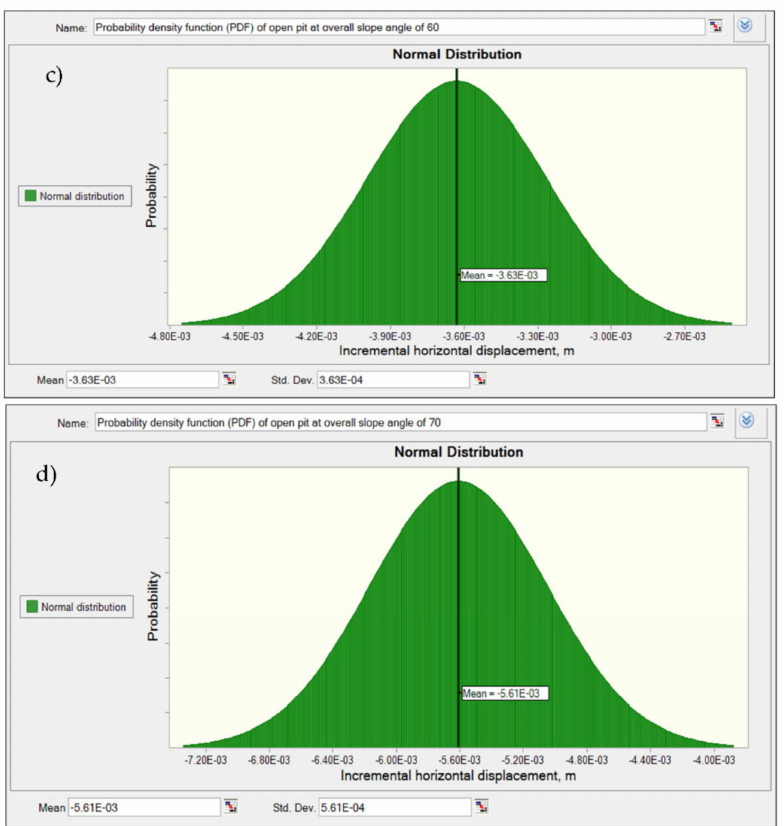
Figure 9. Probability density function (PDF) of incremental horizontal displacement at different overall slope angles: ( a ) P f at overall slope angle of 40 ◦ , ( b ) P f at overall slope angle of 50 ◦ , ( c ) P f at overall slope angle of 60 ◦ and ( d ) P f at overall slope angle of 70 ◦ .